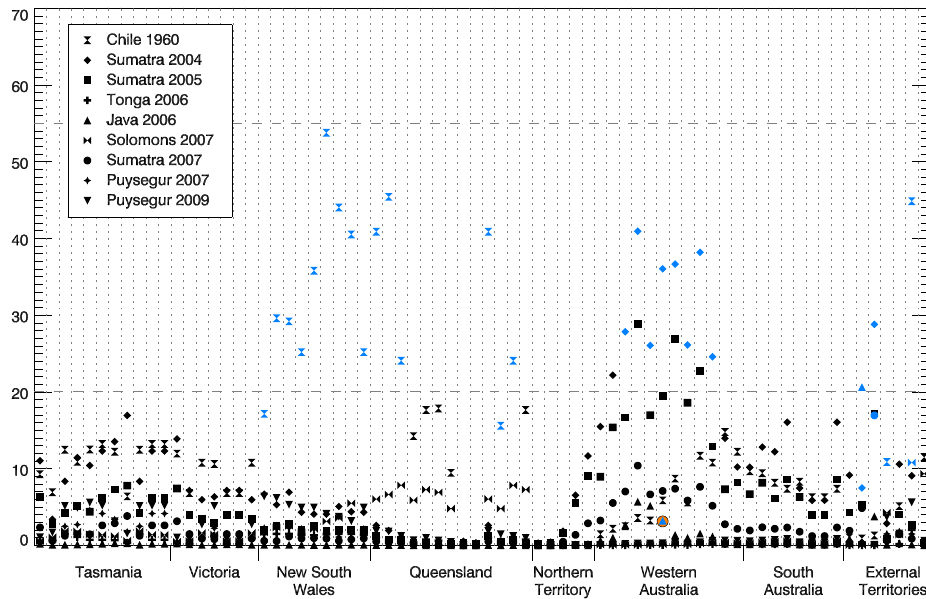
Fig. 8. 95th percentile values of H max in each of the coastal polygons for all events considered in this study. External territories are towards the right-hand side of the figure. For each event, marine warnings were desired in the regions marked by blue symbols. The orange symbol in the lower right is described in Sect. 4.4. The thresholds from Sect. 3.2 are marked by the dashed lines.